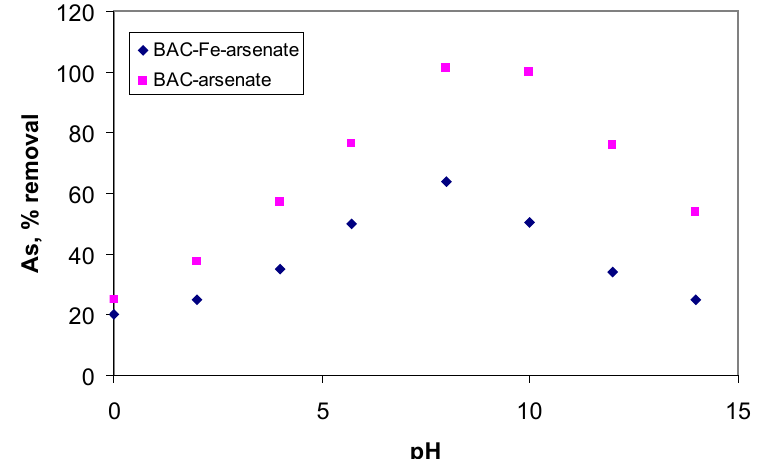
Figure 6. Study of the adsorption of arsenate on sorbents as a function of pH. Conditions: 100 μg L -1 arsenate, pH 9.0.